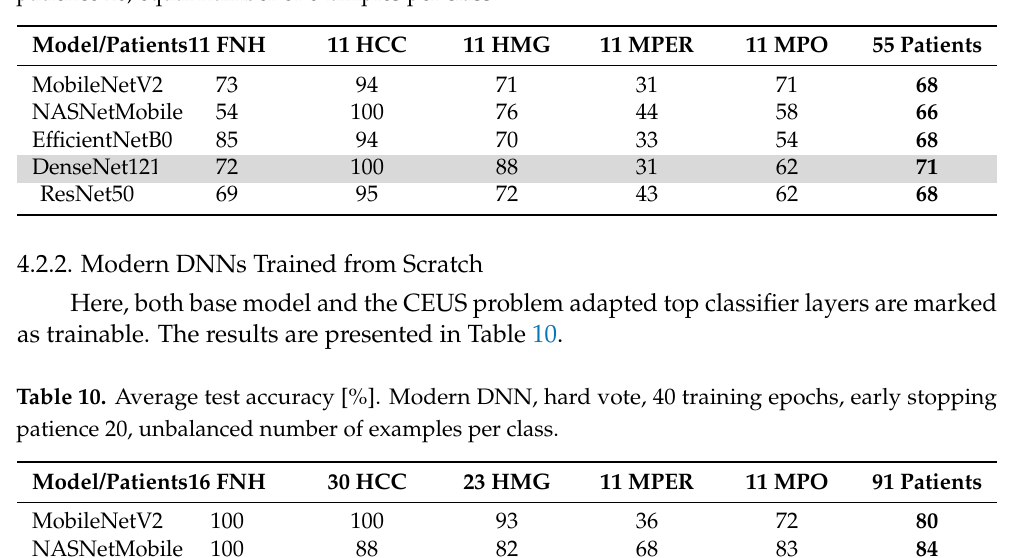
Table 9. Average test accuracy [%]. Modern DNN, hard vote, 40 training epochs, early stopping patience 20, equal number of examples per class.